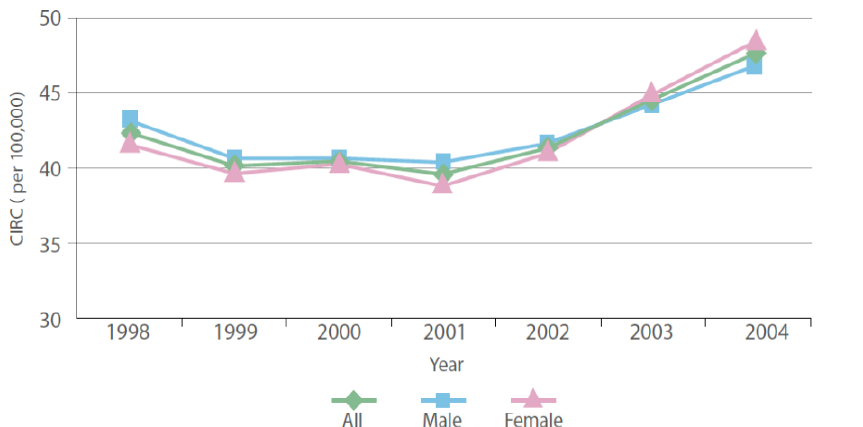
Figure 2. Crude incidence rate (CIR) of all cancers by